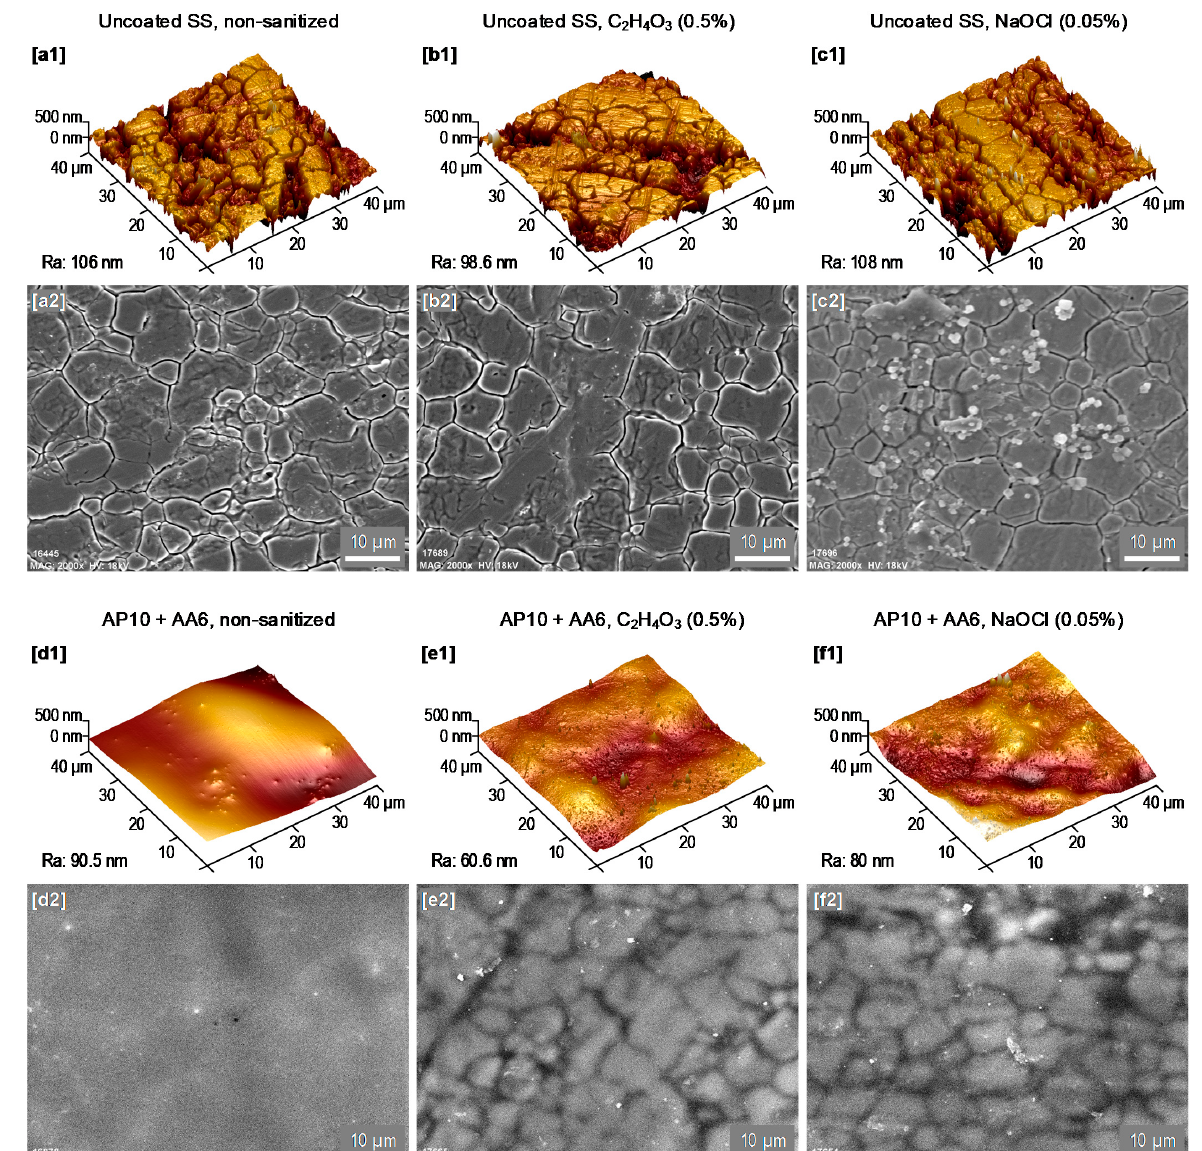
Figure 2. ( 1 ) AFM images (40 × 40 µm) and ( 2 ) SEM images (×2000) of ( a – c ) the uncoated SS and ( d – f ) the coating in three sanitization scenarios: non-sanitized and after five sanitization cycles with peracetic acid (0.5%) and sodium hypochlorite (0.05%).